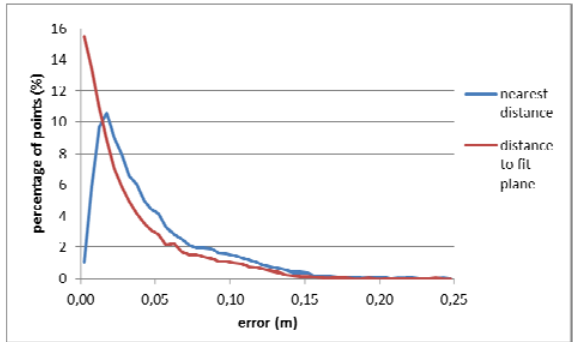
Figure 5. Histogram of relative accuracy in the ITS coordinate system.